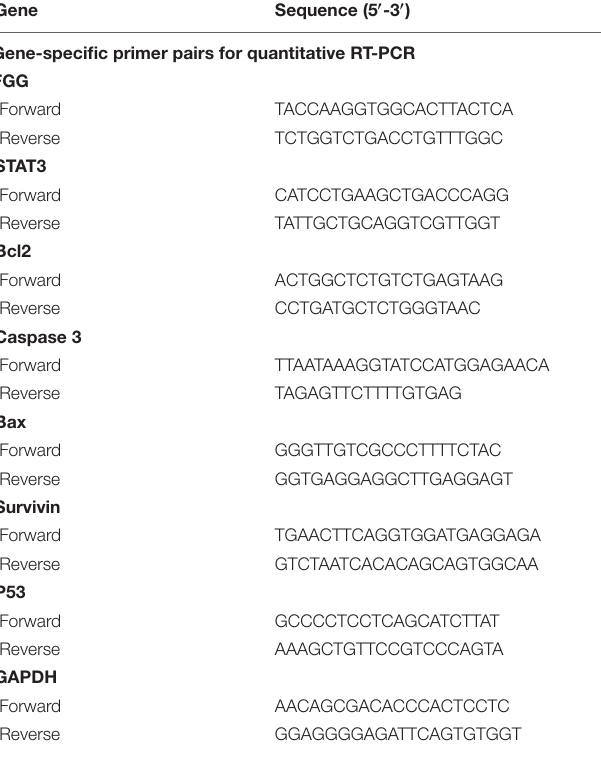
Table 2 . The 2 − (cid:49)(cid:49) Ct method was used to calculate relative gene expression levels.